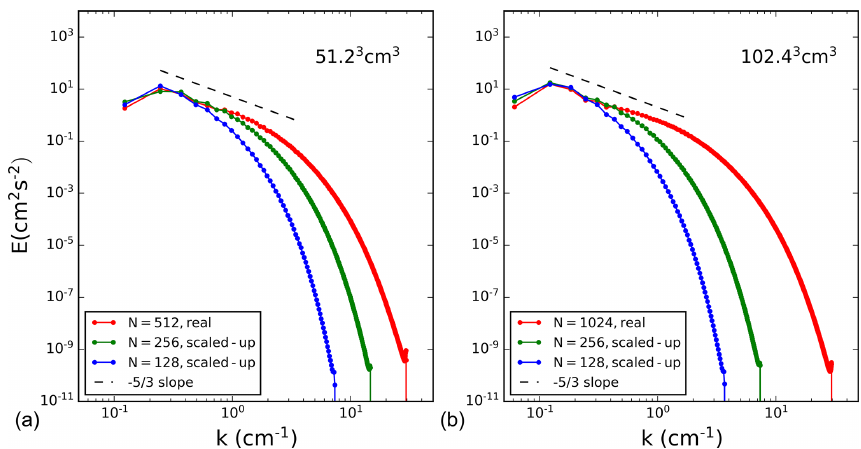
Figure 3. Energy spectrum comparison of real DNS and scaled-up DNS. Panels (a, b) correspond to 512 3 / 1024 3 real DNS.